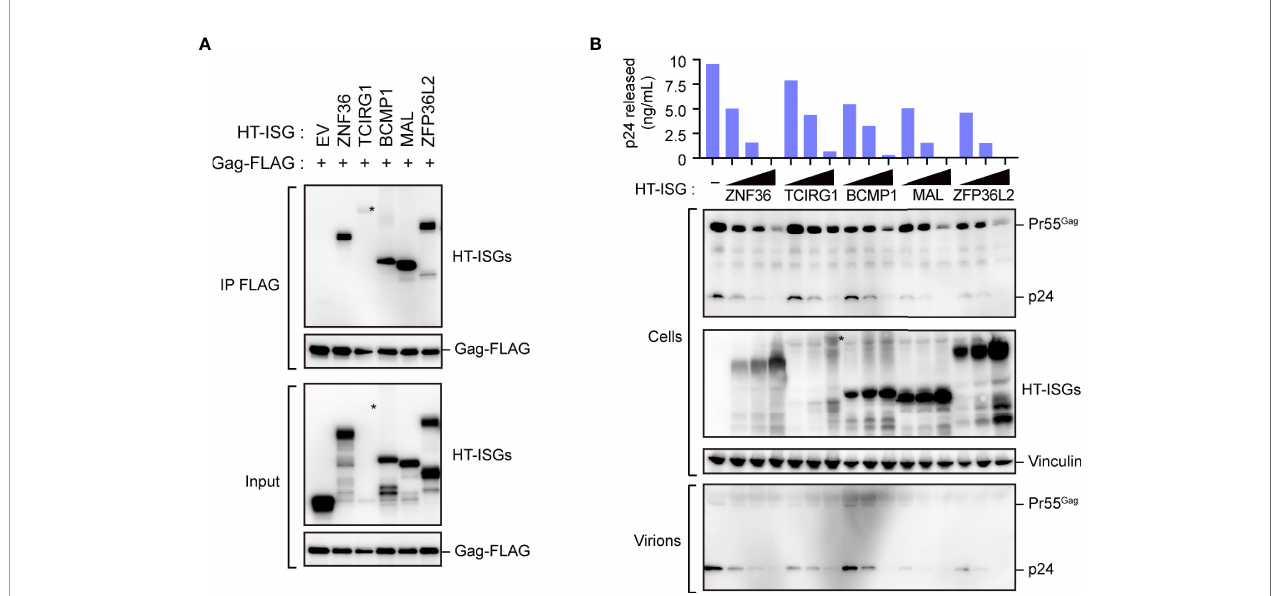
FIGURE 2 | Characterization of Gag-binding proteins. (A) Immunoprecipitation of HEK293 cells with Gag-FLAG and indicated HaloTag (HT)- interferon-stimulated gene (ISG)-encoded protein expression vectors. Cell lysates were precipitated with anti-FLAG, followed by immunoblotting. Asterisks on the blot indicate TCIRG1 expression. Longer exposure blot of input sample is shown in Supplementary Figure S2A . (B) HIV particle production assay. HEK293 cells were co-transfected with the HIV molecular clone pNL4-3 and the indicated ISG-encoded protein expression vectors. Two days post-transfection, cell lysates (Cells) and the culture supernatants (Virions) were subjected to immunoblotting. Viral p24 antigen in the culture supernatants was measured by